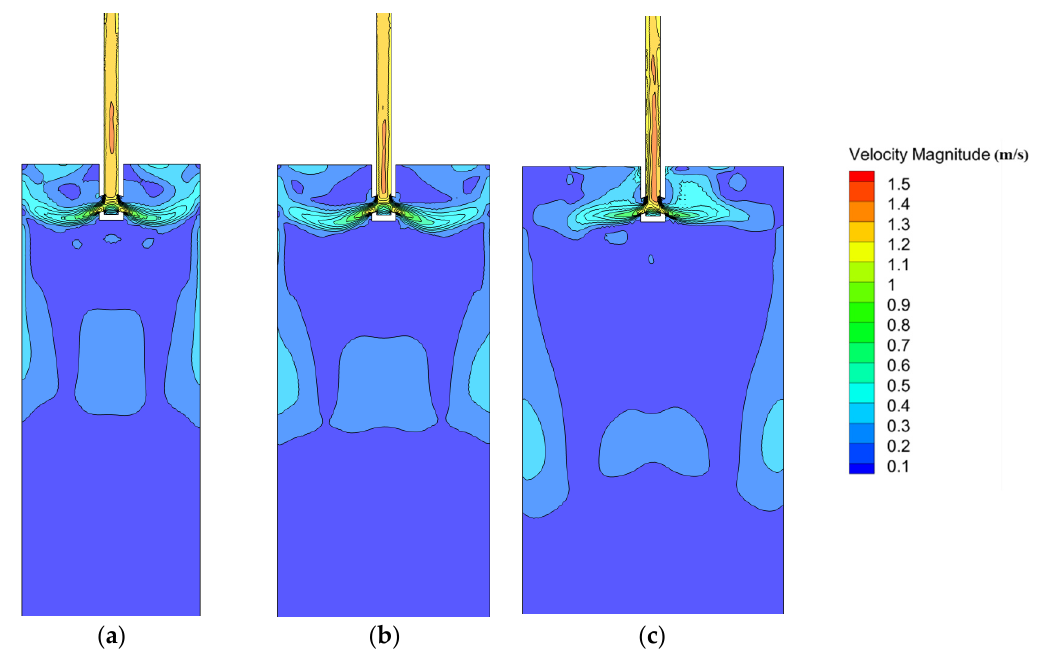
Figure 4. Velocity contour on the center longitudinal section of the mold with different mold widths under low steel throughput: ( a ) 880 mm, ( b ) 1050 mm, and ( c ) 1300 mm.